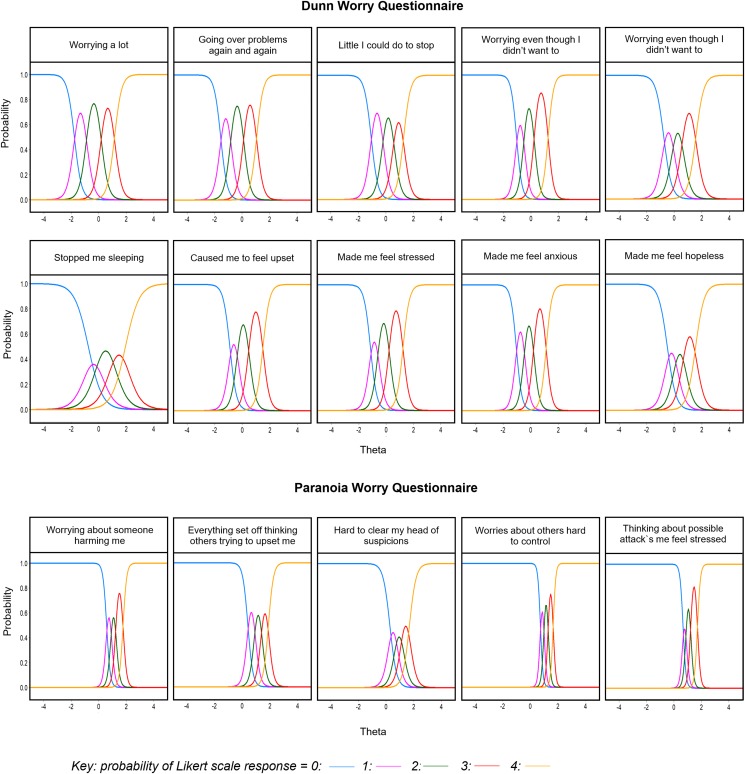
Category response curves (CRCs) for the Dunn Worry Questionnaire and Paranoia Worries Questionnaire. The lines represent the probability (y axis) of responding to each Likert scale option (0–4) across the distribution of θ (x axis) for each item.